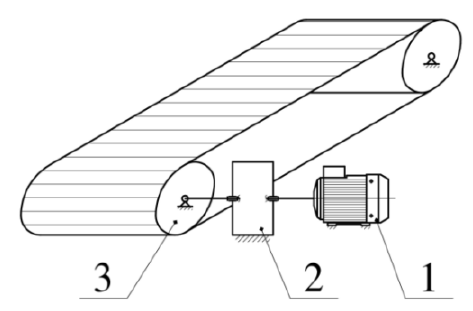
Figure 1. Scheme of the conveyor actuator.